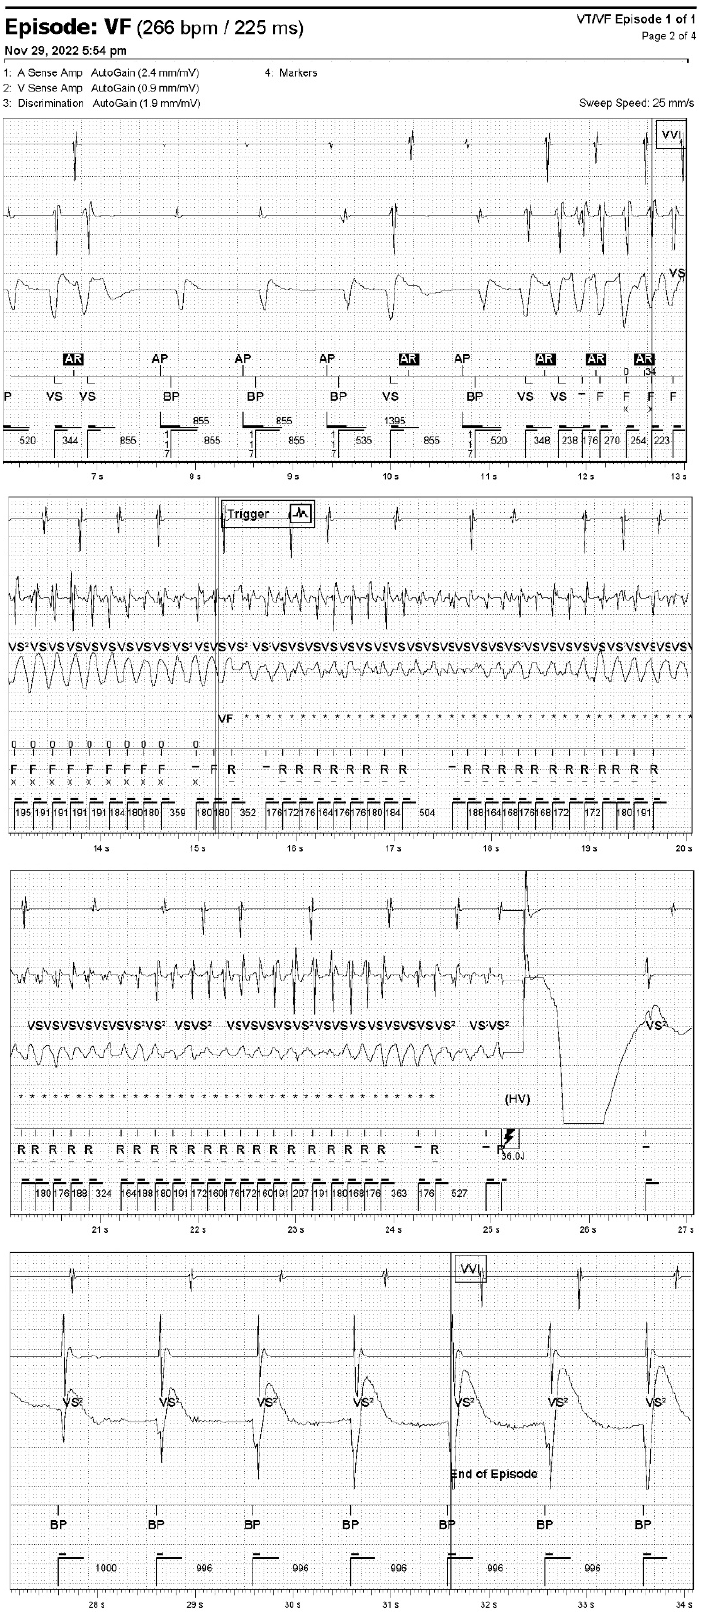
Figure 3. Remote diagnostics of ventricular fibrillation (VF) via smartphone app. Intracardiac electrogram of VF episode recorded by cardiac resynchronization therapy defibrillator and sent via Bluetooth smartphone app remote monitoring on 29 November 2022. *, capacitor charging